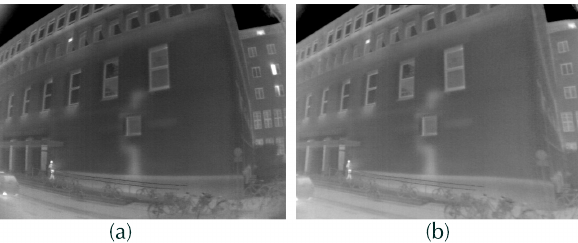
Figure 3. Image calibration. (a) Example of orginal image. (b) Corresponding rectified image.